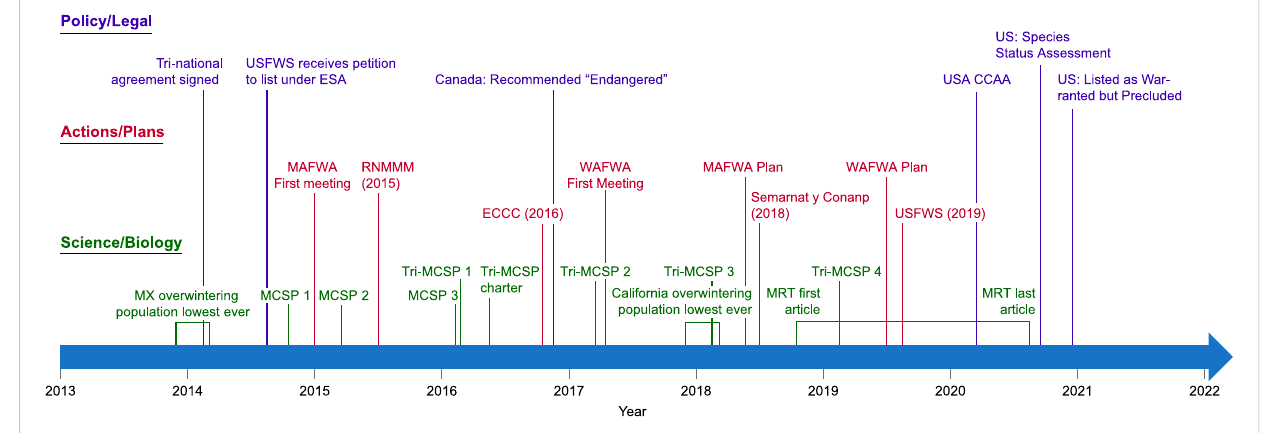
FIGURE 4 Monarch timeline showing policy activities, MCSP meetings, actions, and years of critical lows in populations size. Some actions and plans are labelled as they are cited and can be found in the literature cited. ECCC, Environment and Climate Change Canada; MAFWA, Midwest Association of Fish and Wildlife Agencies; RNMMM, Red Nacional de Monitoreo de la Mariposa Monarca en México; WAFWA, Western Association of Fish and Wildlife Agencies; MRT, Monarch Research Topic (Diffendorfer et al., 2020). The Monarch Joint Venture publishes an annual Monarch Conservation Plan (Monarch Joint Venture, 2021), which we did not include in the timeline. IMMP sampling began in 2016 and